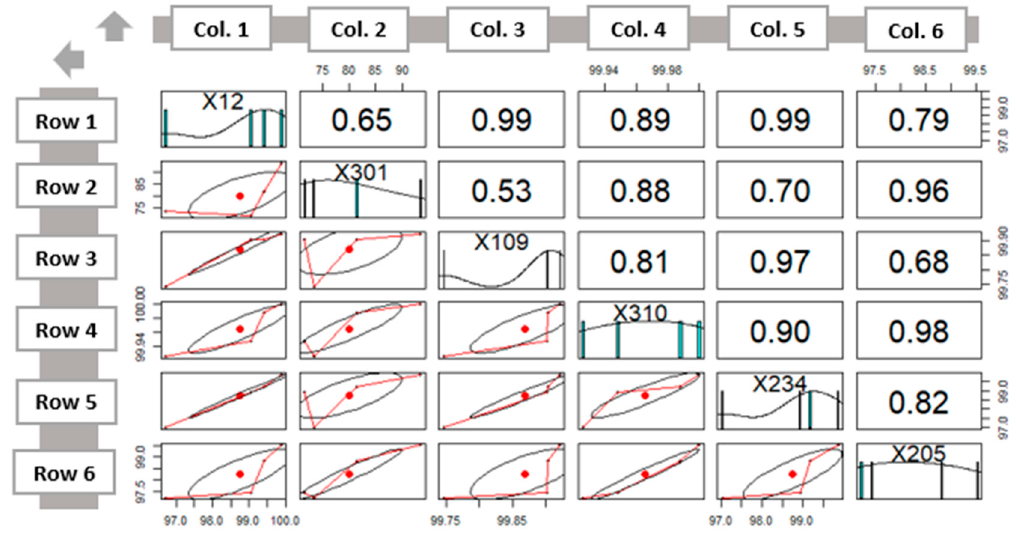
Figure 6. Contingency table for the Co-Active elements in the ‘SO107’ group. Notes: * = Co-Active coefficient corresponding to “Row 1”, “Col. 4”.